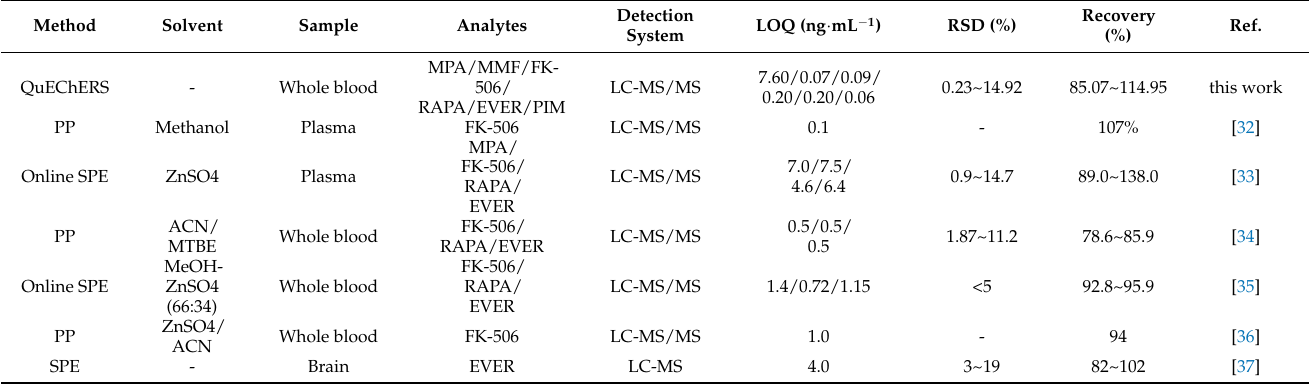
Table 3. Comparison of the developed method to the other approaches used in the extraction of